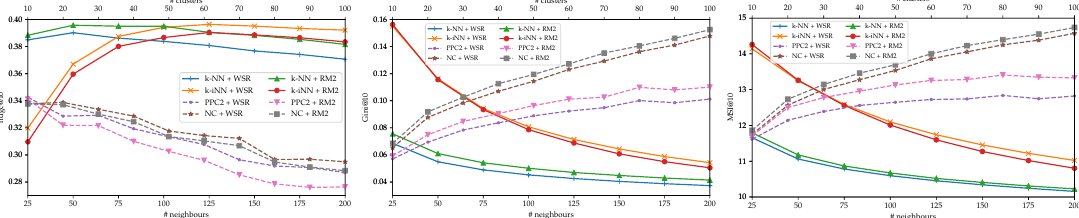
Figure 1. Values of nDCG@10, Gini@10 and MSI@10 of all studied algorithms when varying the number of clusters or